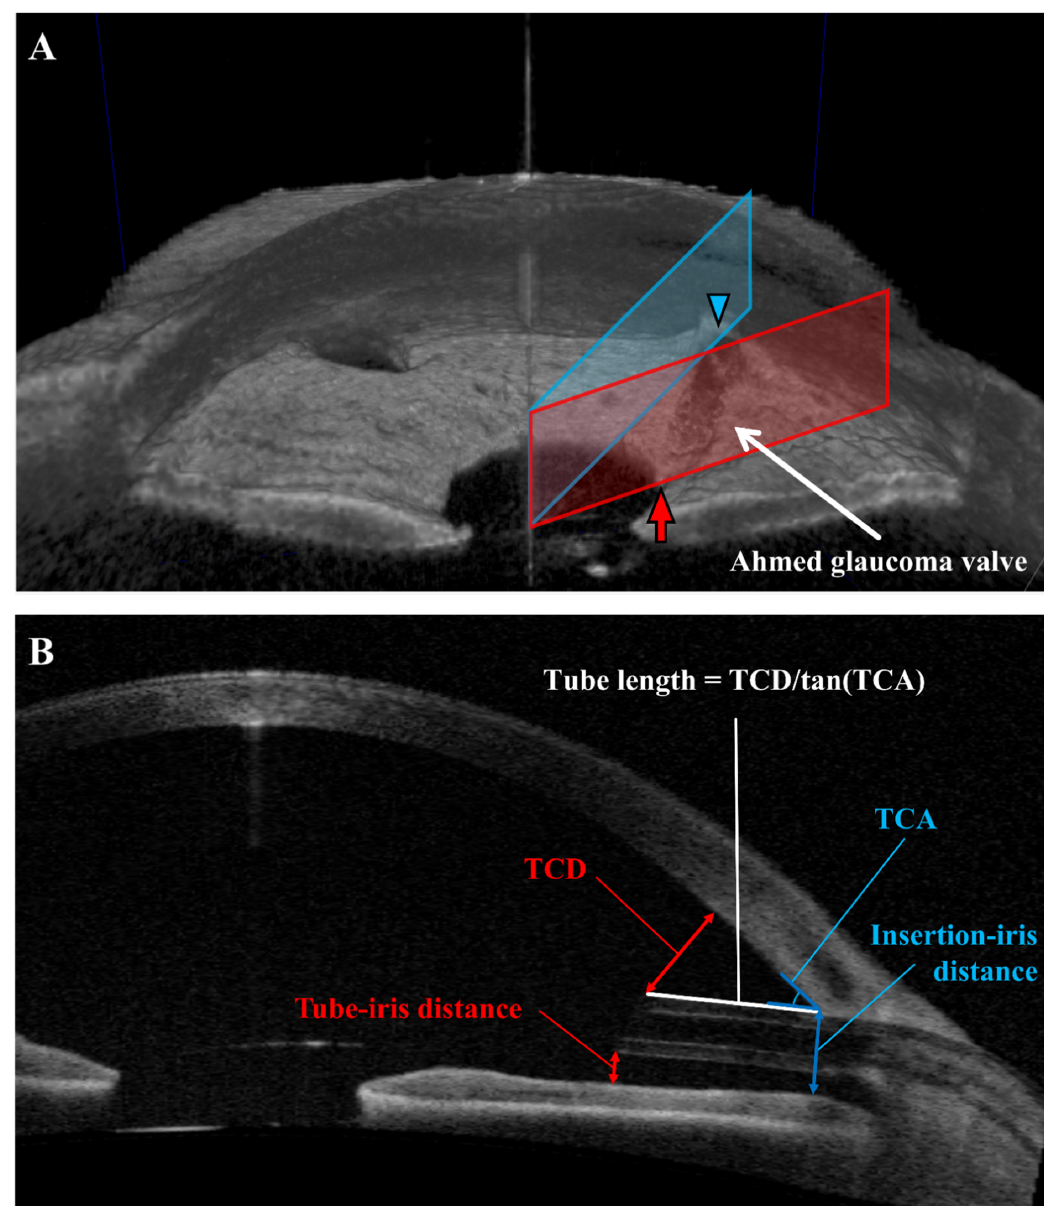
Figure 1. Measurement of tube parameters using anterior segment optical coherence tomography (AS-OCT). Two cross-sections either including depictions of the tube tip (red) or the tube insertion (blue), respectively, are shown in this 3D view. The red arrow indicates the tube tip, and the blue arrowhead shows the insertion site of the tube ( A ). Tube–corneal distance (TCD), tube–iris distance (TID), tube–corneal angle (TCA), and insertion–iris distance (IID) were measured directly, and tube length (TL) was computed as follows: TCD/tan (TCA). The cross-section in this figure was selected from a patient, wherein the tube tip and the insertion site could be seen in the same cross-section plane ( B ).